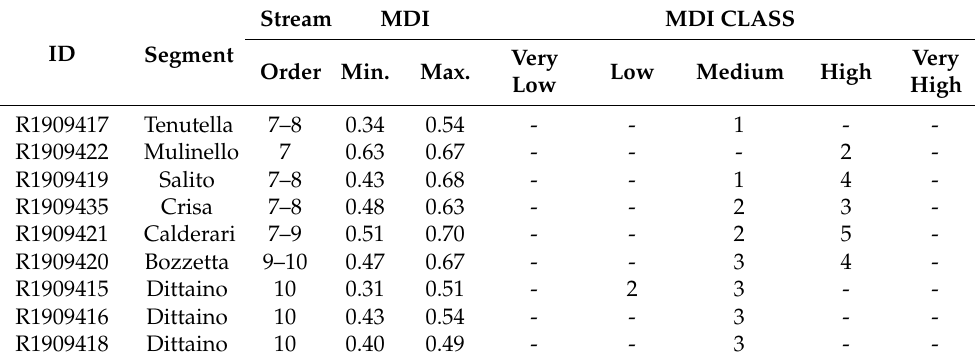
Table 10. Minimum and maximum MDI values for each segment and MDI class for each analyzed reach of the Dittaino’s fluvial